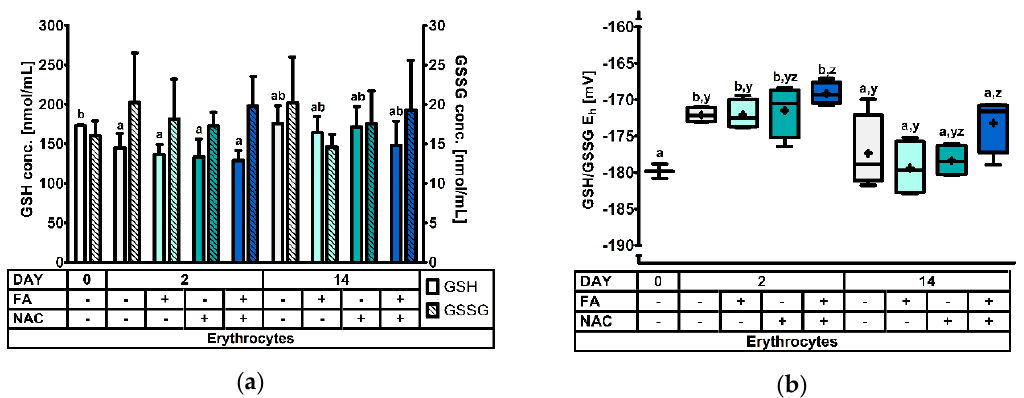
Figure 1. The glutathione redox system in erythrocytes of piglets at d0, d2, and d14 post-weaning (DAY), either ad libitum fed (FA − ) or fasted (FA+) the first 2d post-weaning, and either provided standard drinking water (NAC − ) or water supplemented with 200 mg/L N -acetyl cysteine (NAC+) during the first 14d post-weaning. Results are presented as least squares means with SD. Significance levels of main effects and interaction terms are presented in Table 3: ( a ) Erythrocyte glutathione (GSH) and glutathione disulphide (GSSG) concentrations. a,b Represent the effect of DAY across other factors ( p ≤ 0.05); ( b ) Erythrocyte glutathione redox status (GSH/GSSG E h ). a,b Represent the effect of DAY across other factors ( p ≤ 0.05). y,z Represent the effect of FA × NAC across DAYS ( p ≤ 0.05).